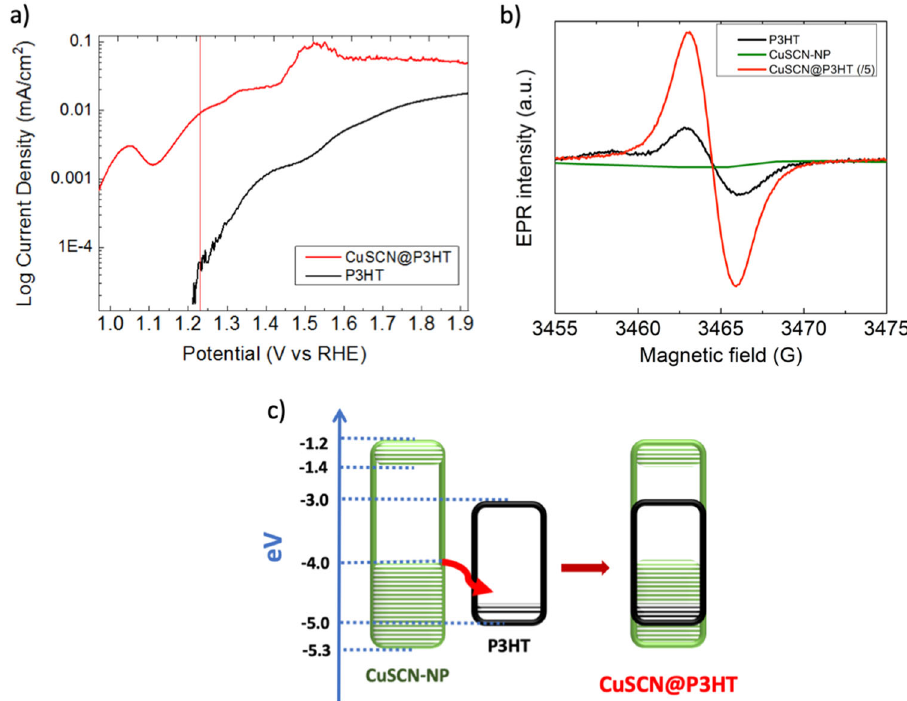
Fig. 2 Electrochemical and physico-chemical characterization of the CuSCN@P3HT blend. a Linear sweep voltammetries in the anodic regime of CuSCN@P3HT-based (red line) and P3HT (black line) working electrodes. b EPR spectra in dark at low temperature of pristine P3HT, CuSCN-NP, and CuSCN@P3HT. The amount of P3HT across the two different samples is the same. For the sake of clarity, the EPR signal for CuSCN@P3HT is reduced by a factor of 5. c Energy levels diagram of CuSCN@P3HT (right), illustrating qualitatively the hole transfer process obtained after blending CuSCN-NP with P3HT (left). The P3HT work function value was taken from previous reports of some of us 21,47 . The dashed areas qualitatively represent fi lled states in CuSCN-NP (green) and in CuSCN@P3HT